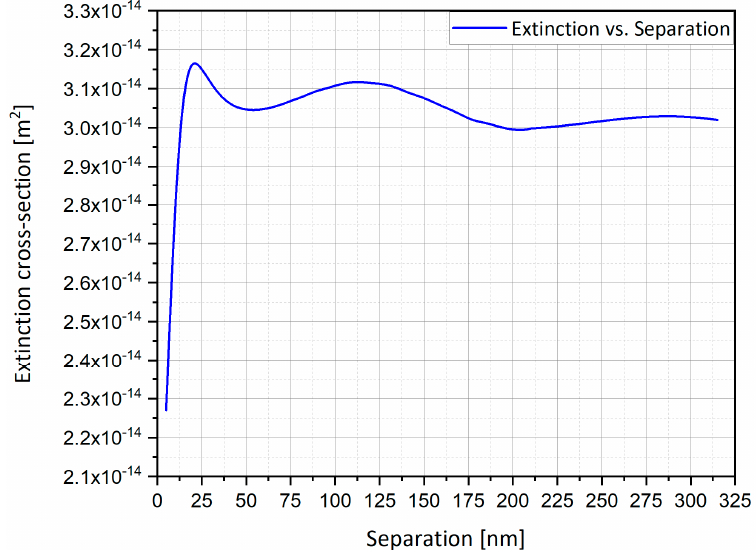
Figure 21. Extinction cross-section vs. separation for four silver spheres in an oscillating electric field in the Y direction.